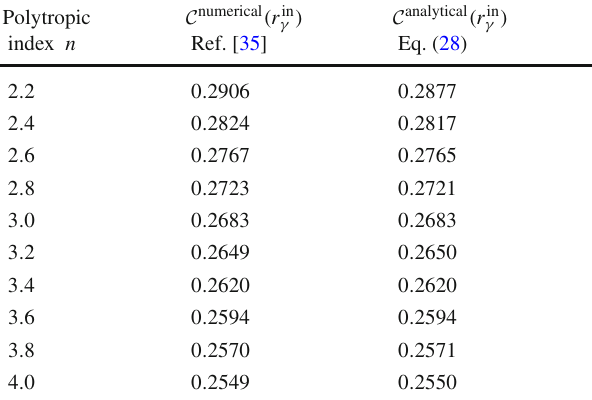
Table 1 Ultra-compact polytropic fluid spheres with light rings. We present, for various values of the polytropic index n , the numerically computed [35,41] 8 dimensionless compactness parameter C numerical ( r in γ ; n ) of the isotropic matter configurations. We also present the corresponding values of the dimensionless compactness parame- ter C analytical ( r in γ ; n ) as calculated directly from the simple analytical fit (28). One finds a remarkably good agreement between the numerical results [35] and the analytical formula (28). In particular, one deduces from (28) the characteristic asymptotic value C ( r in γ ) → 0 . 2149 < 1 /